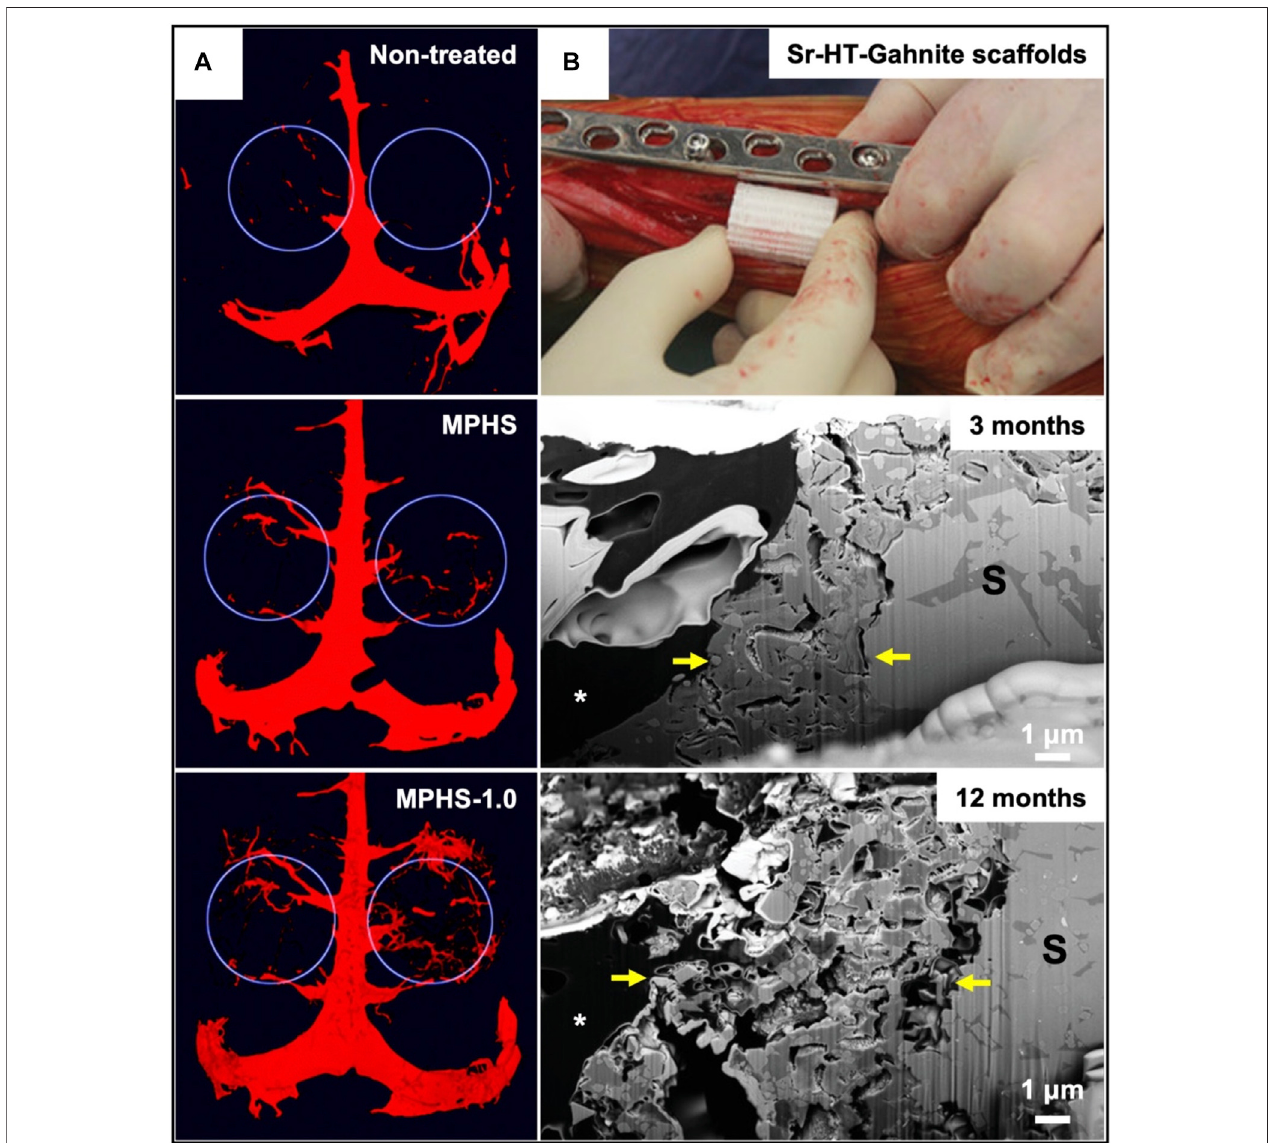
FIGURE 4 | (A) Microscopic CT evaluation of vascular reconstruction in the defect area (showing white circles) at 8 weeks after implantation of MPHS and MPHS- DMOG scaffolds. Reproduced with permission (Min et al., 2015). Copyright 2015, Royal Society of Chemistry. (B) The surgical procedure for implanting the 3D printed bioactive ceramic scaffold into the bone defect and FIB-SEM shows the cross section of the implant bone interface. A broken boundary (between the yellow arrows) represents a ceramic disintegration area. At 12 months, the boundary became more prominent and in fi ltrated by loose connective tissue. Reproduced with permission (Li JJ. et al., 2019). Copyright 2019,